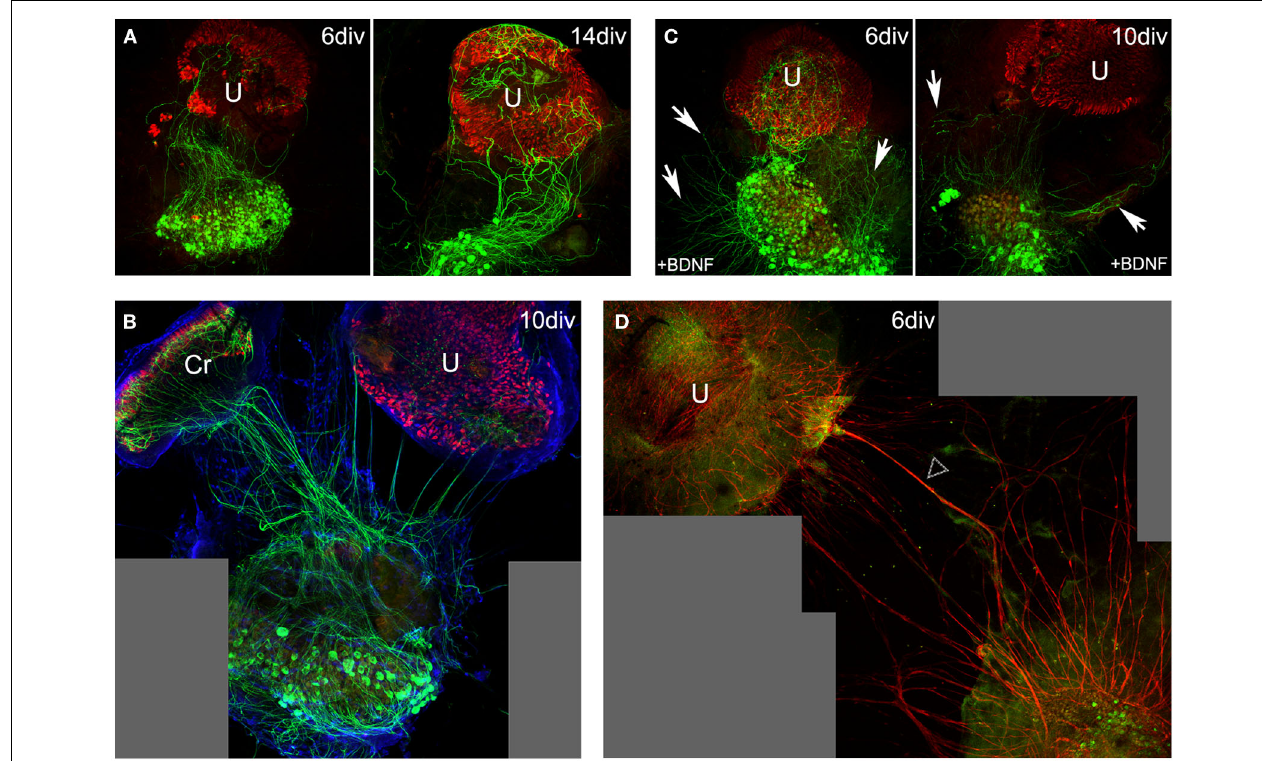
FIGURE 1 | Neurite outgrowth in 6–14DIV co-cultures from P3–8 rodents. In co-cultures of vestibular ganglion, crista (Cr), and utricle (U) from P5 mouse (A) or rat (B) pups, neurons extend processes toward the sensory epithelia. Neurofilaments (green) were stained with anti-N52 antibodies, hair cells (red) with anti-calretinin serum, and nuclei (blue) withToPro3.The importance of extrinsic factors was highlighted in these culture conditions (C,D) . BDNF added to the culture medium [P5